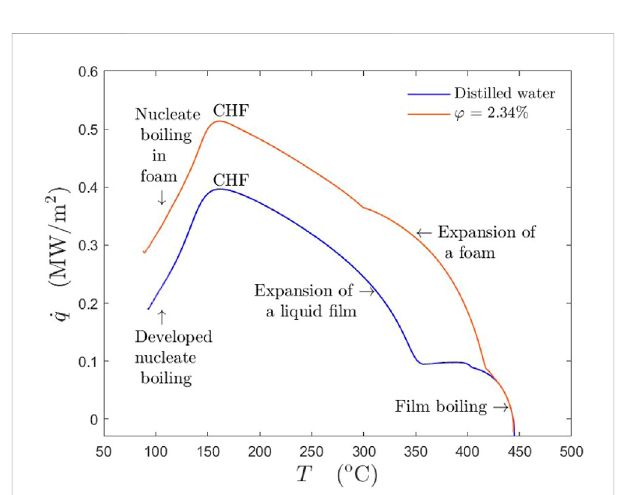
FIGURE 9 Boiling curves for distilled water in comparison with that for a lubricant solution φ = 2.34% for the same initial substrate temperature T w0 =445 ° C.The sprayparametersare: themeandropdiameter 78.7 μ m, the mean impact velocity U = 14.05 m/s and the